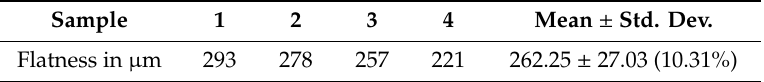
Table 10. Flatness of surface measured with 3D scanning.